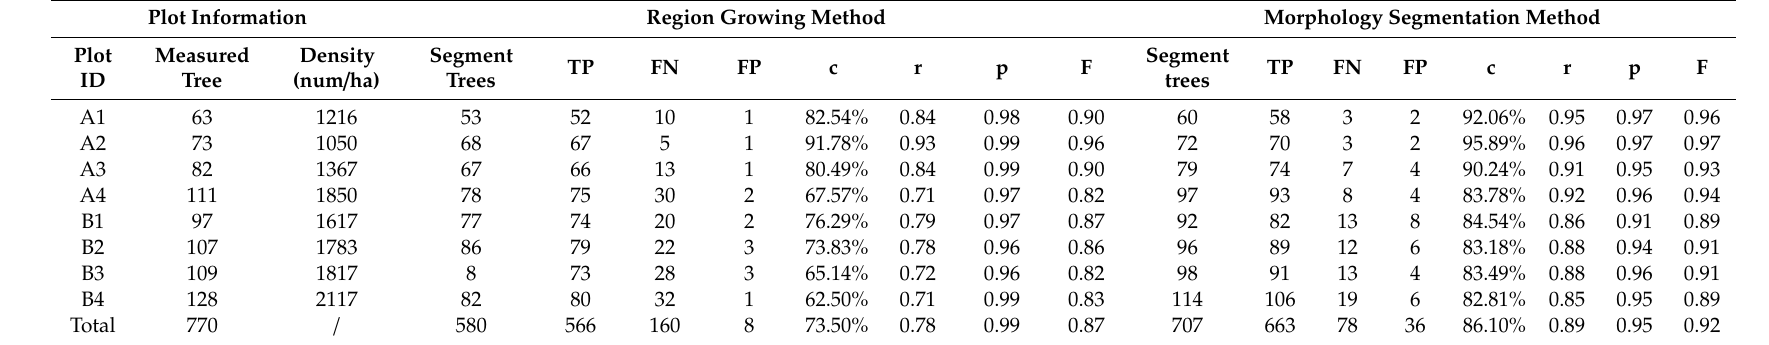
Table 3. The accuracy of individual tree